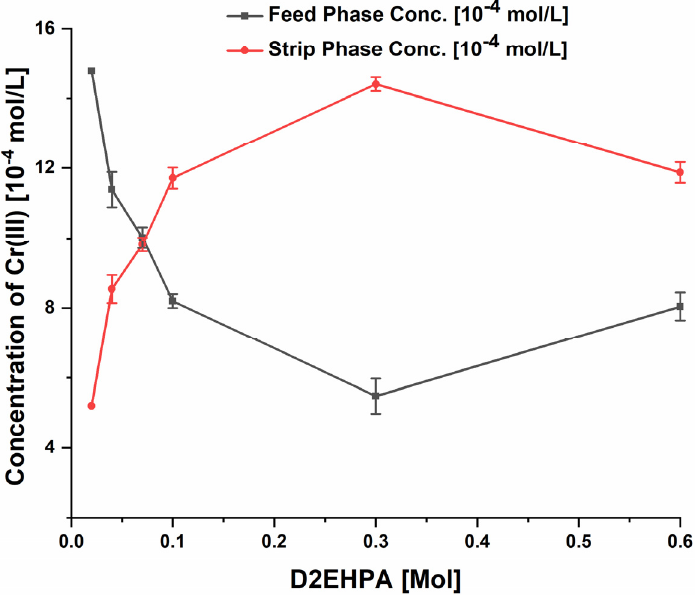
Figure 2. Concentrations of Cr (III) in the feed phase ( a ) and stripping phase ( b ) at 0.6M D2EHPA concentration; [CrIII] = 20 × 10 − 4 mol/L, [HCl] = 1.25 mol/L.